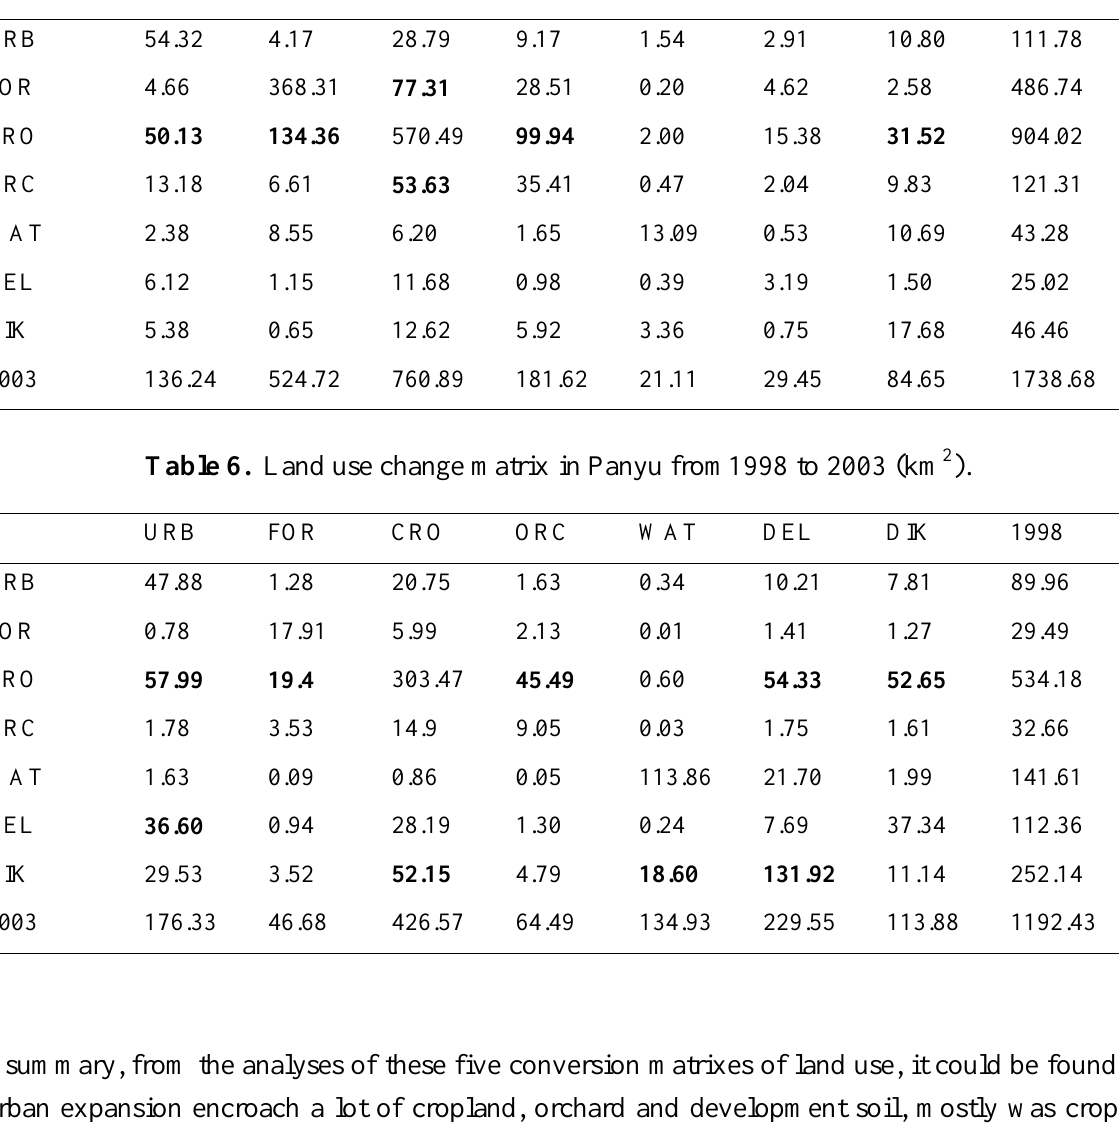
Table 5. Land use change matrix in Zengcheng from 1998 to 2003 (km 2 ). URB FOR CRO ORC WAT DEL DIK 1998 URB 54.32 FOR CRO